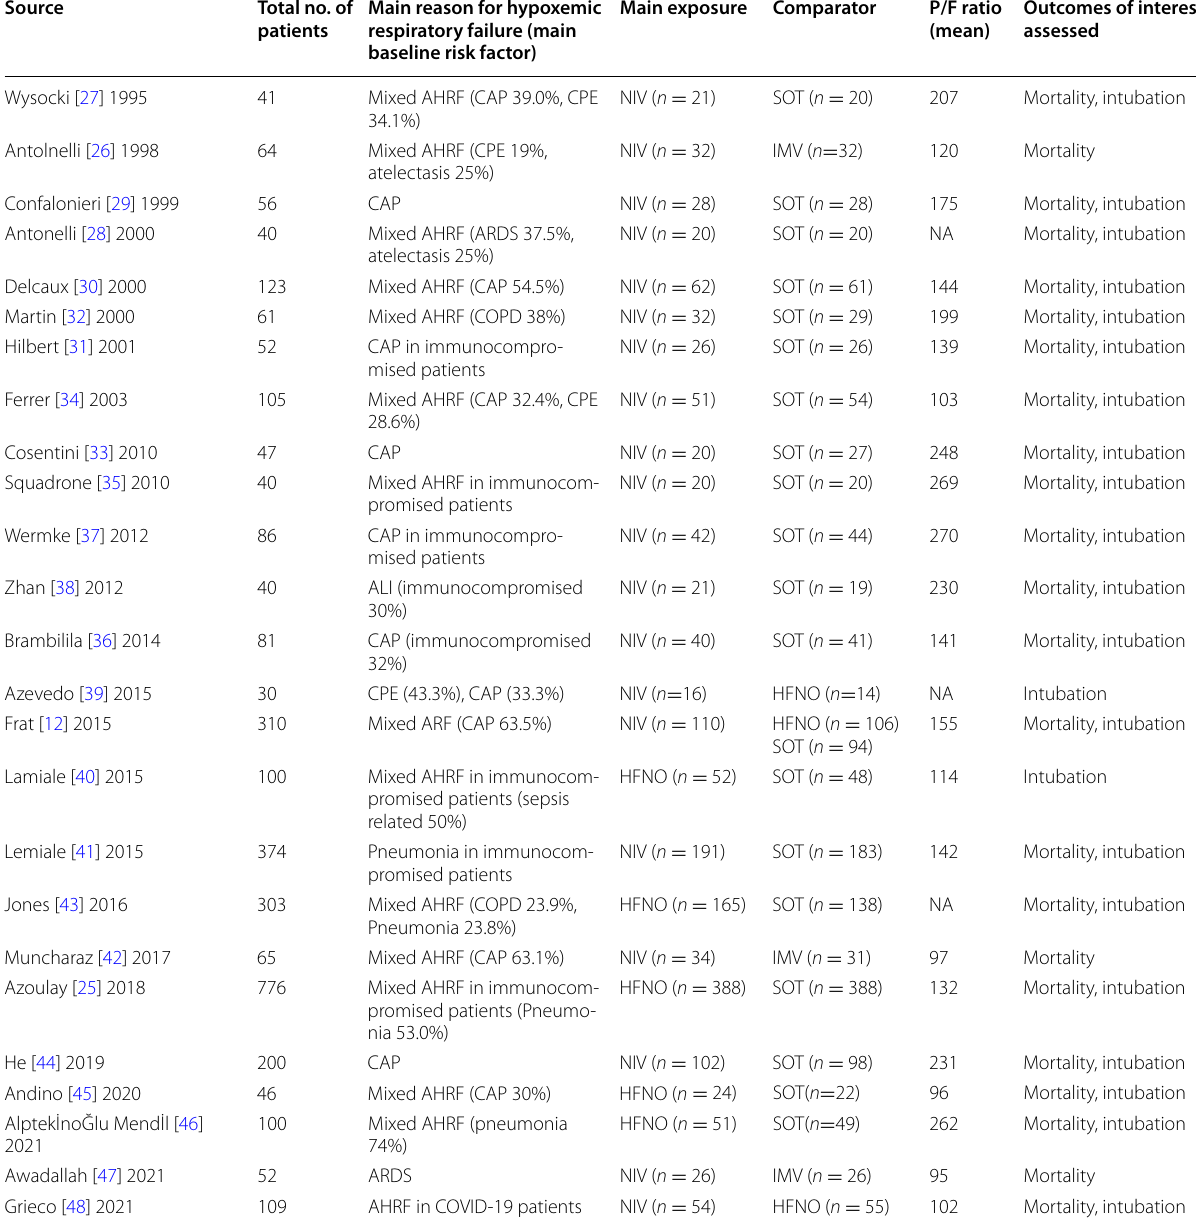
Table 1 Summary of the characteristics of the studies included in the network